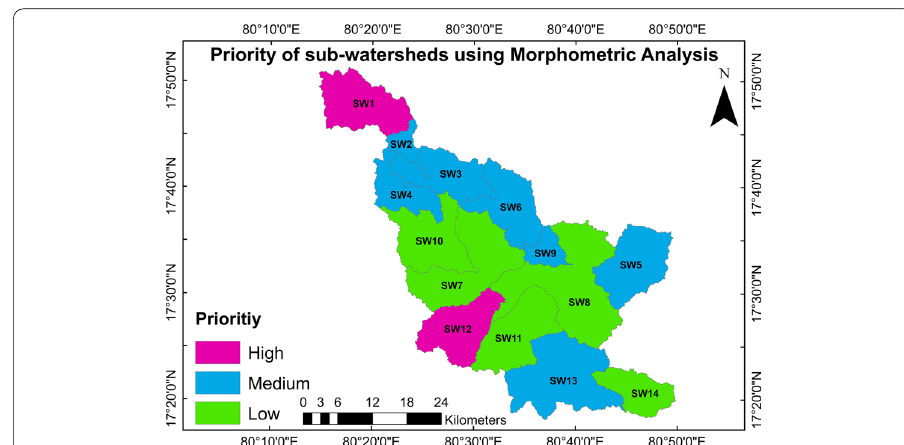
Fig. 8 Priority of sub-watersheds based on morphometric analysis